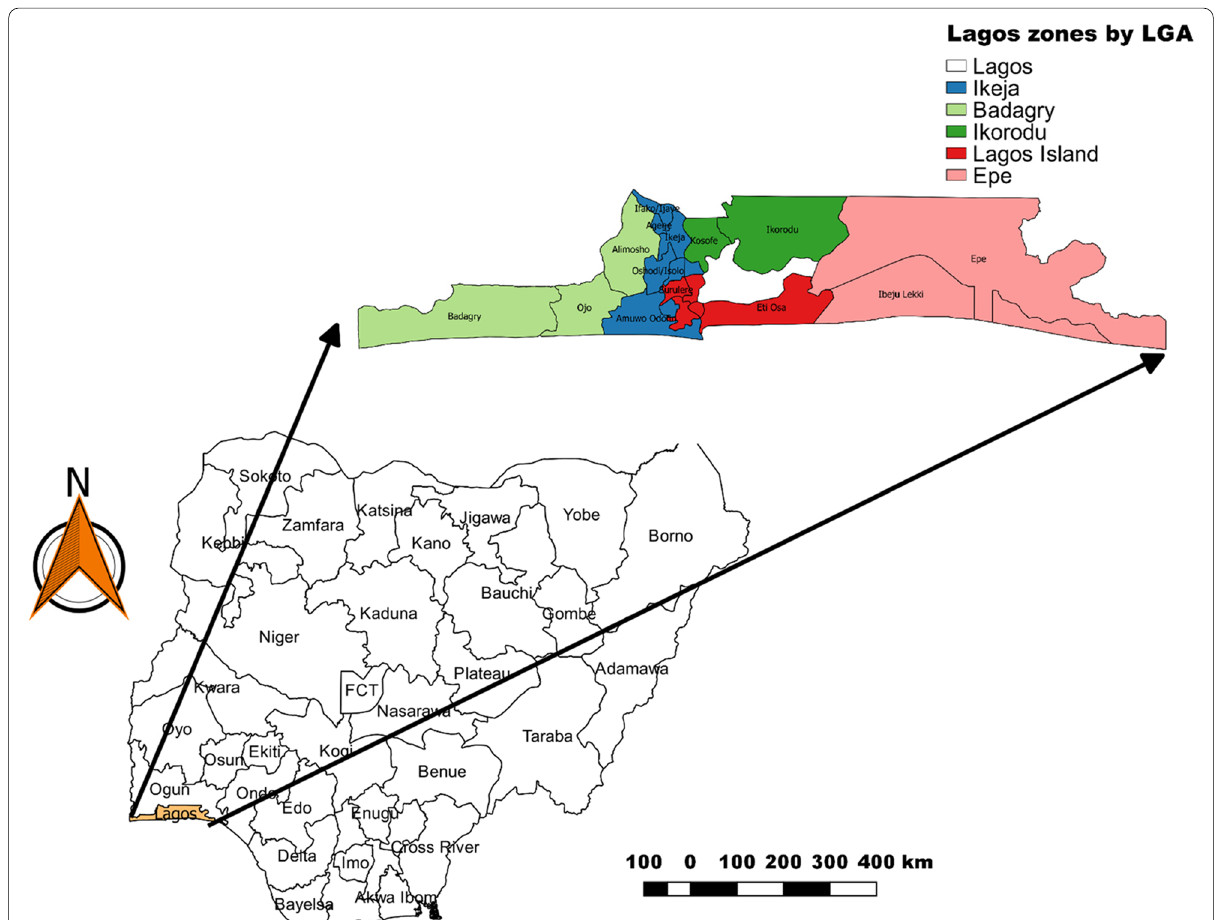
Fig. 1 Map of Nigeria, with the zonal division of Lagos. This shows the map of Nigeria, highlighting the zonal division of Lagos State into five, with each zones representing a different color. The zonal division was used during sampling, to choose the appropriate veterinary clinic to be selected for sample collection for